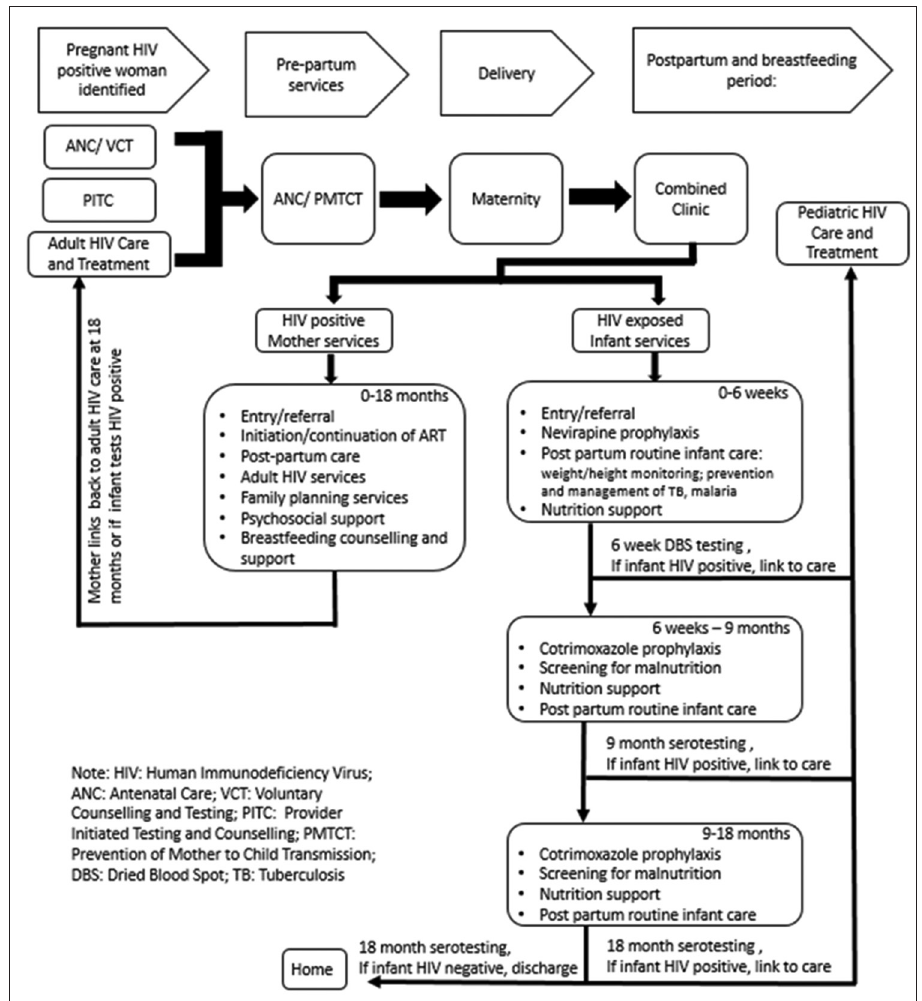
Figure 1 : The “Combined Clinic” Model and Services for Mother and